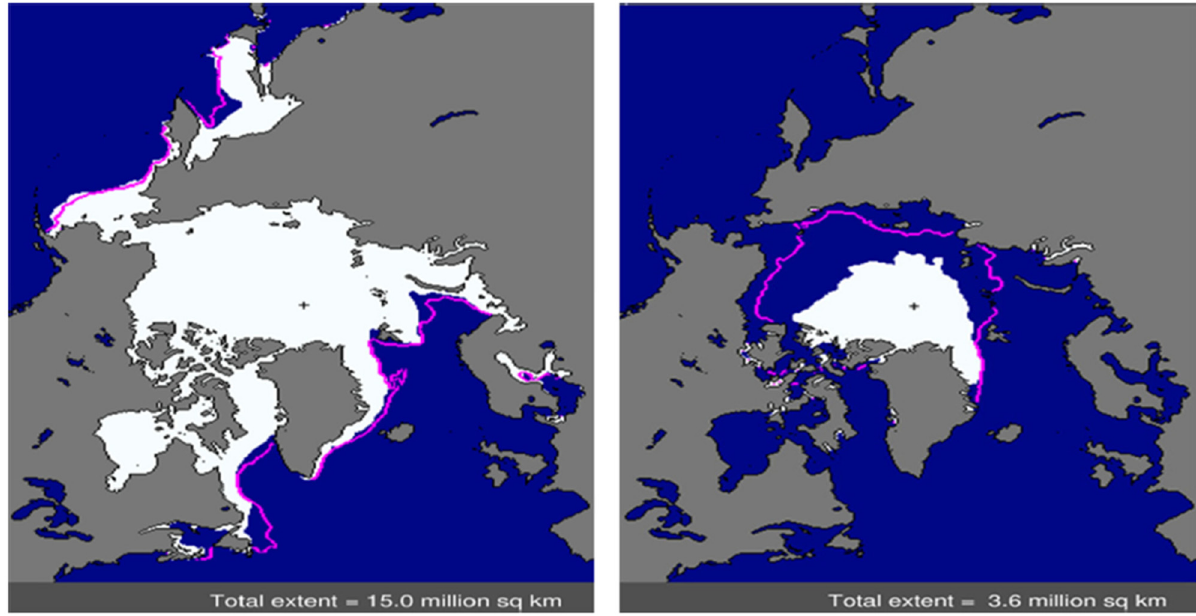
Figure 1: The total sea ice extent in March ( left ) and September 2012 ( right ) . Purple lines re fl ect the median extent from 1979 to 2000 [ 29 ]